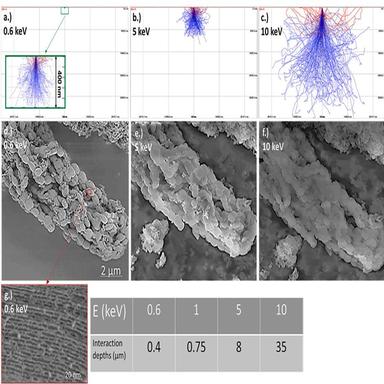
a.) – c.) Monte Carlo simulations of the interaction depths within SBA-15 mesoporous material (Au particles are not included in the simulations and the material density used for the simulation 0.067 g/cm3 ) when the sample is exposed to low energy electron beams in SLEEM with landing energies of 0.6 keV, 5 keV, and 10 keV (CASINO®,https://doi.org/10.1002/sca.20000). The red paths are of those backscattered electrons (BSEs) that have left the sample. d.) – f.) The corresponding SLEEM images obtained with the